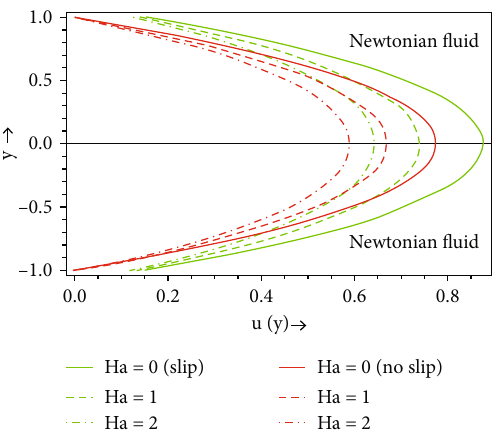
Figure 9: Variation of velocity with electrical conductivity ratio.